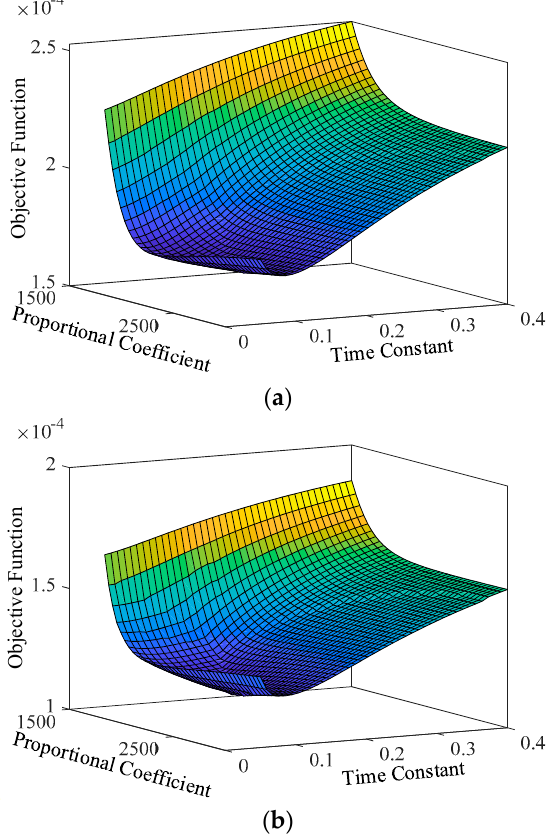
Figure 7. The relation between objective function J , proportional coefficient K, and time constant T with: ( a ) α = 0.3; ( b ) α = 0.7.